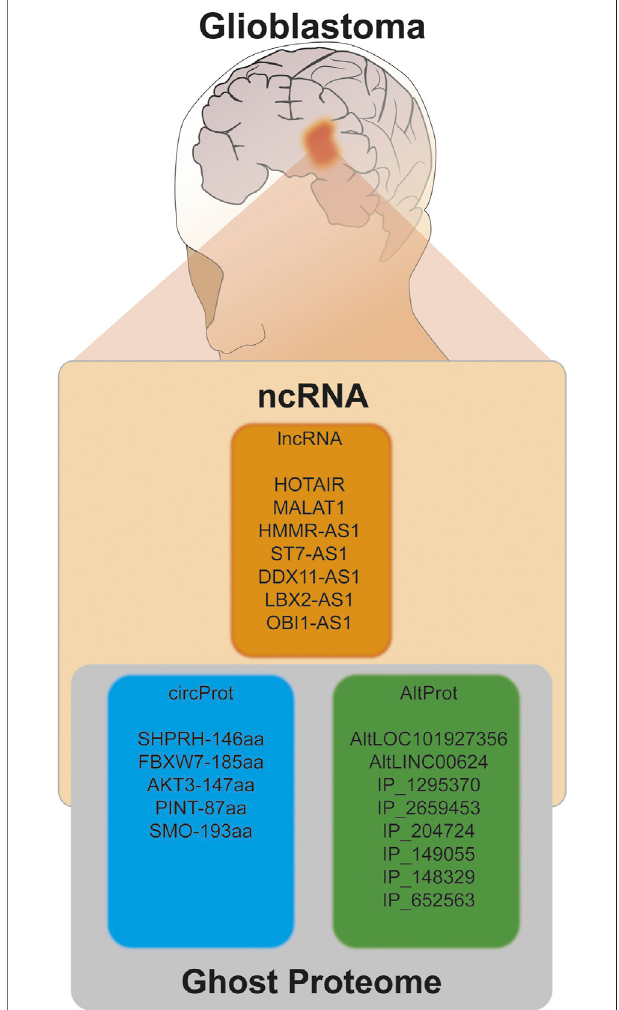
FIGURE 6 | Summary of different hidden players that are involved in the pathology of